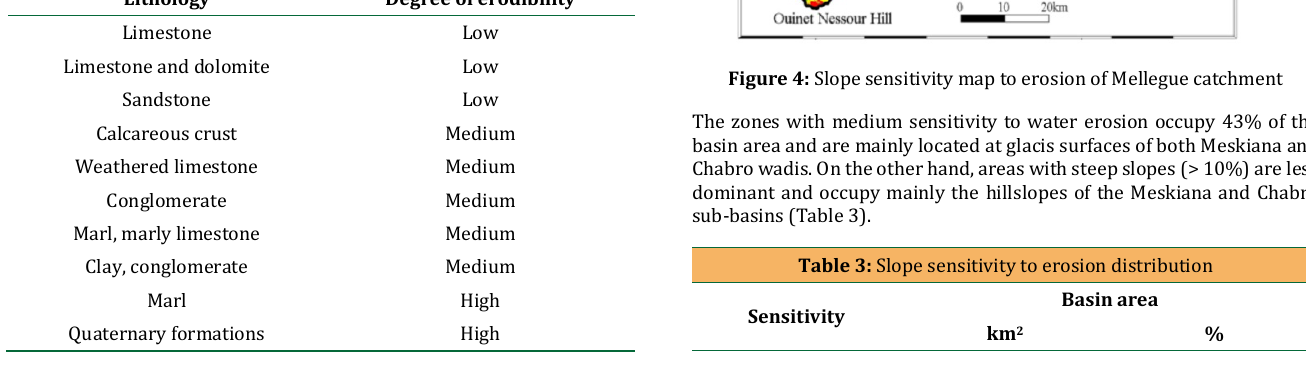
Classification of rocks according to their resistance to erosion Lithology Degree of erodibility